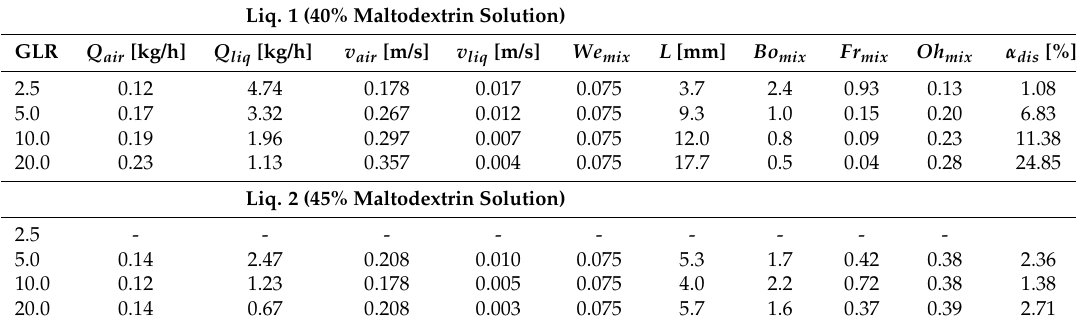
Table 5. Working parameters of the CFT